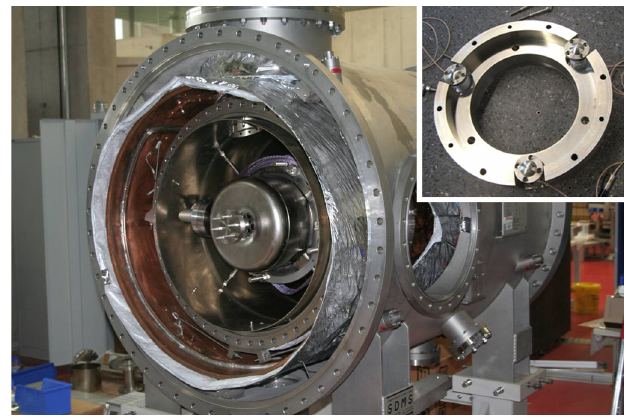
FIG. 1. (Color) 360 MHz prototype CH cavity implemented in the horizontal cryomodule with a picture of the piezo tuning